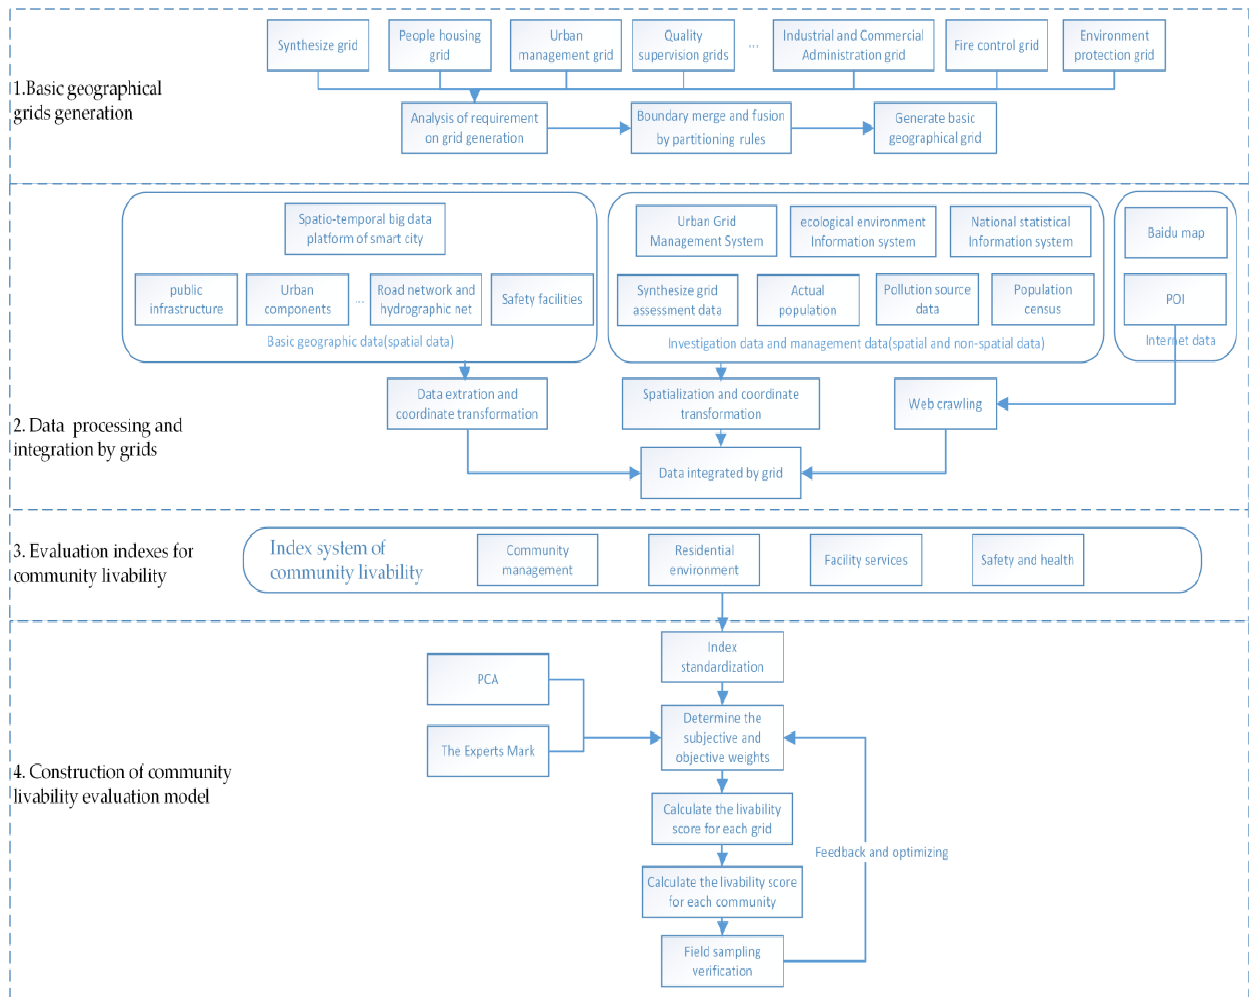
Figure 2. An approach to community livability evaluation mainly using gridded basic urban geo- graphical data.